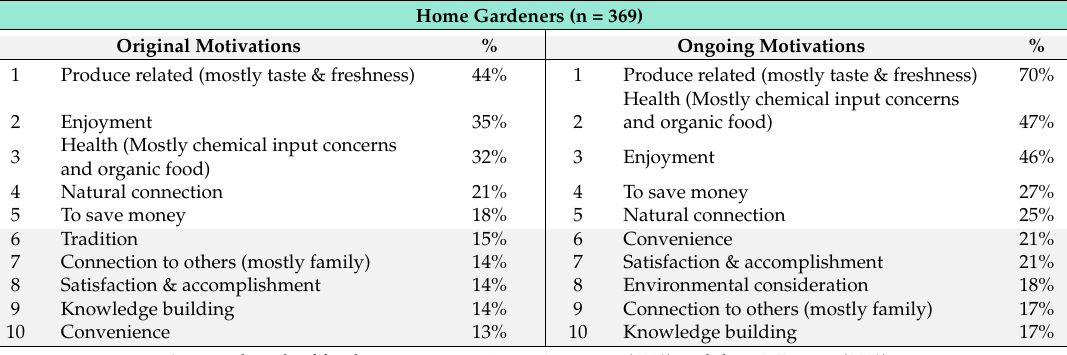
Table 1. The top 10 original and ongoing motivation categories of Edible Gardens home gardeners.